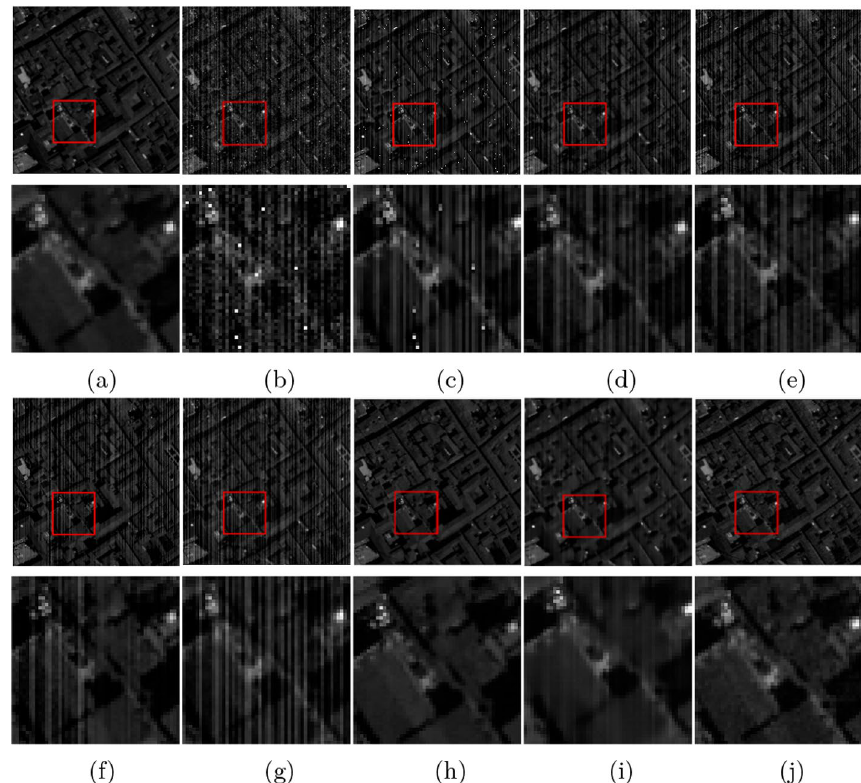
Fig. 1 The Pavia City Center image (4th band) [top] and zoom-in image [bottom] before and after denoising in Case 1.3 with σ 0.05 and o 0.01, r 0.7, v 0.075. a Original image; b Noisy image; the denoising = = = = results obtained by c BM4D; d LRMR; e NAILRMA; f LLRGTV; g MTGSNMF; h SSTVSSLR; i HSI-SDeCNN; j